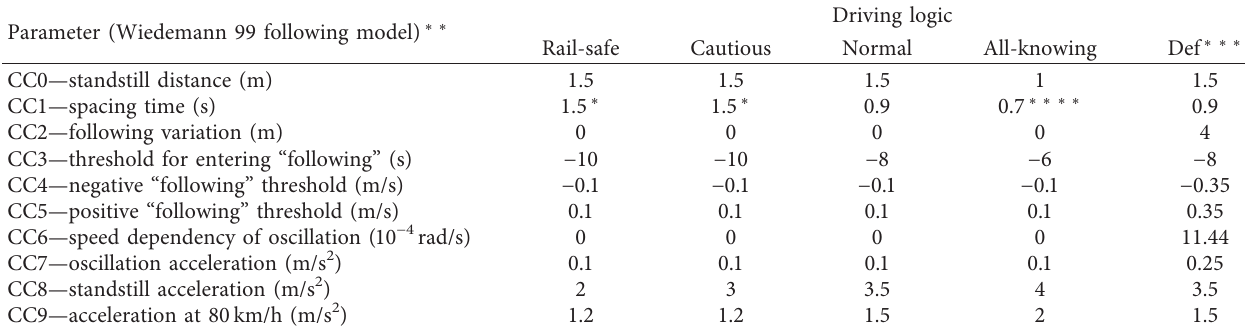
Table 2: Recommended driving behaviour parameters for following in Vissim.